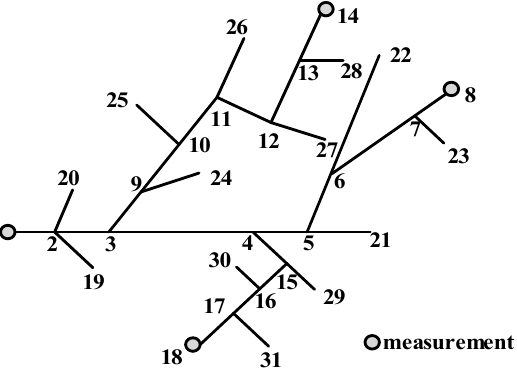
Figure 6. A multi-level branch distribution network.